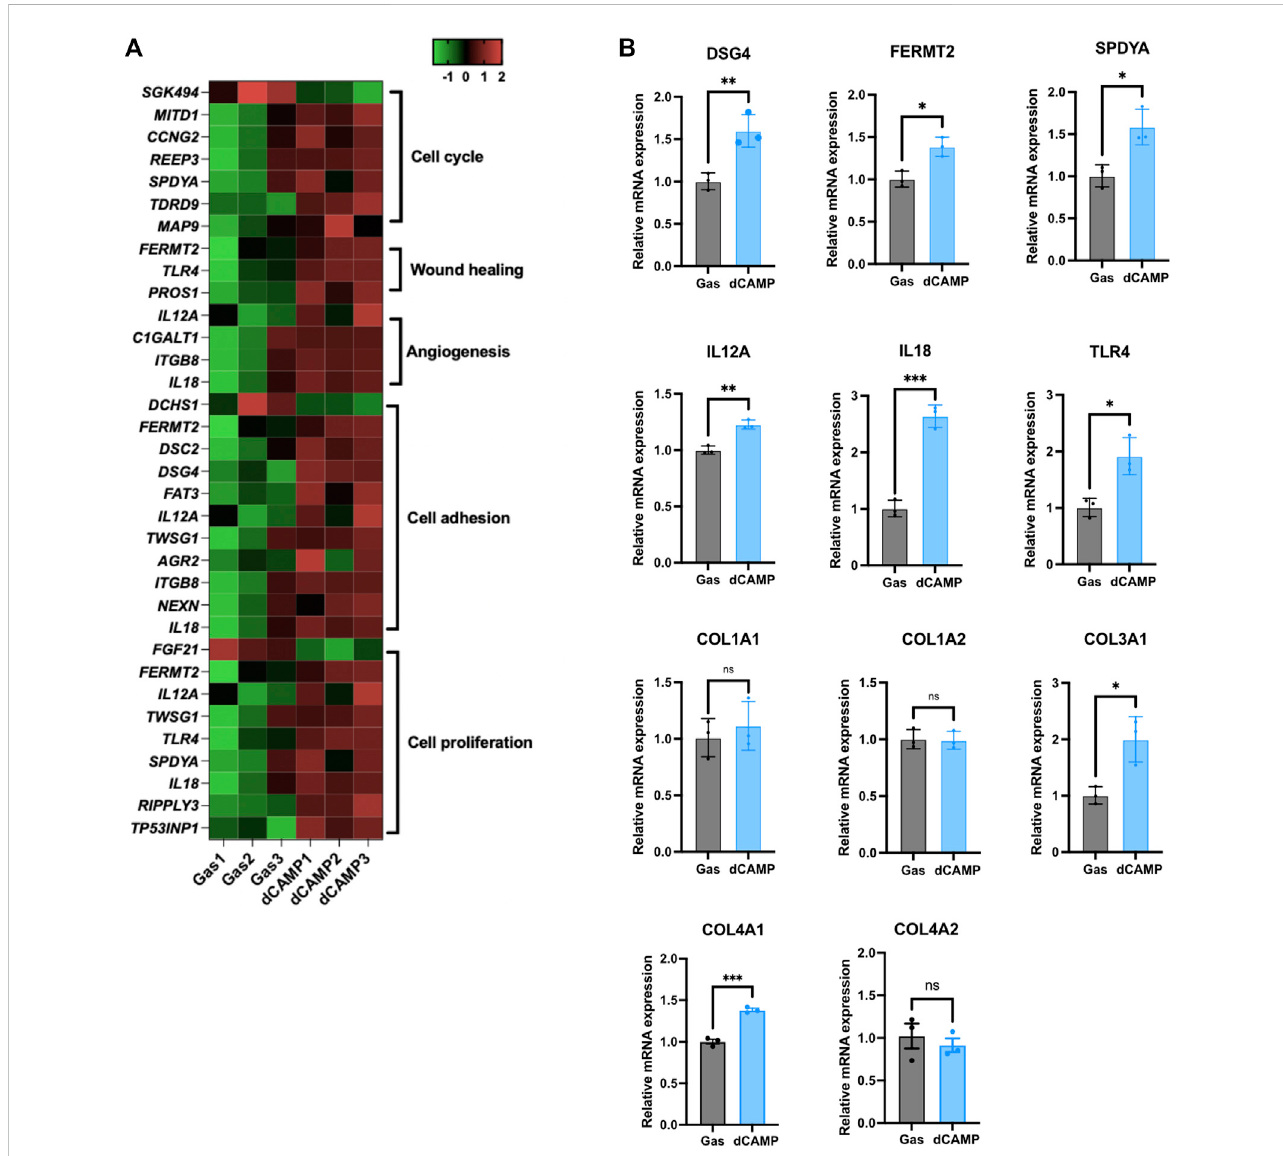
FIGURE 5 dCAMP treatment upregulated target genes associated with wound healing in CPEK cells. (A) Heatmap represents the gene regulated by dCAMP in various pathways; raw data was obtained from GO analysis. (B) mRNA expression analysis by qRT-PCR shows that dCAMP regulated expression of various genes in the wound-healing process, consistent with the enrichment analysis results. Data are presented as mean ± standard error, * p < 0.05, ** p < 0.01, and *** p < 0.001 compared with the gas-treated